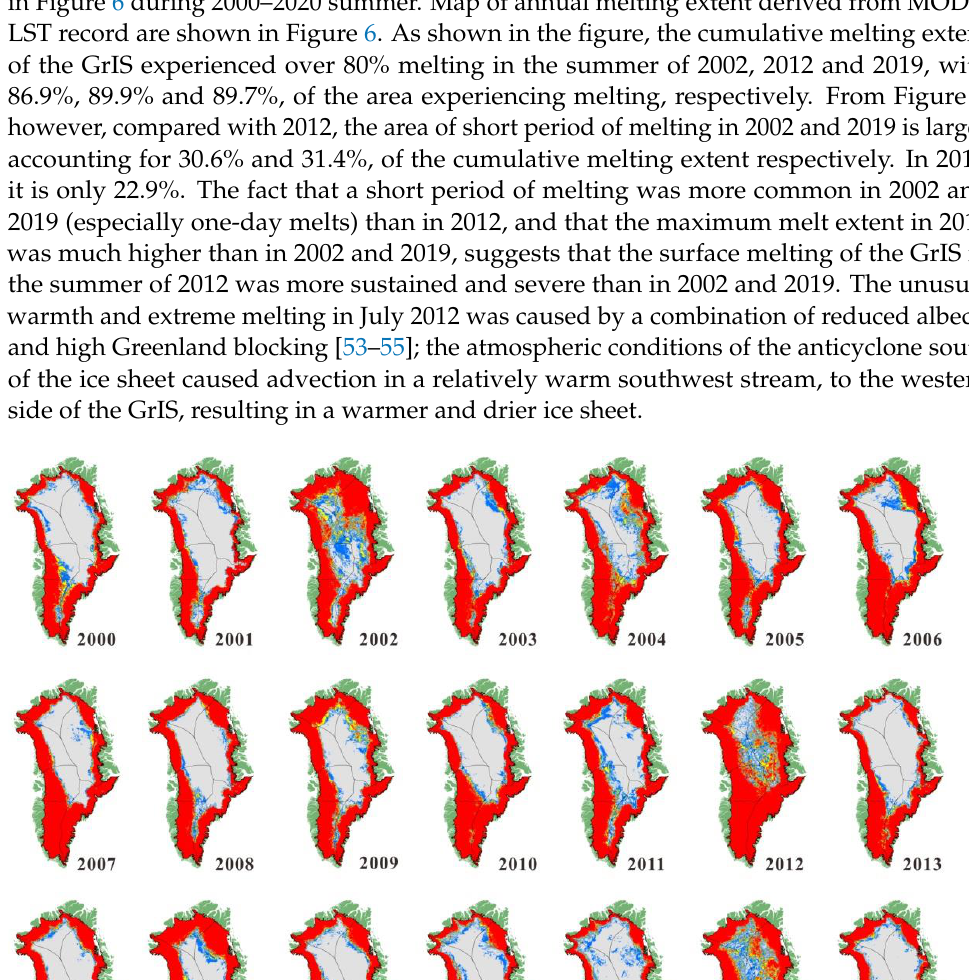
Figure 7. Percentage of the GrIS melting extent for summer from 2000 to 2020. (Extent of maximum melt as derived from the MODIS daily LST). Apparently, in the summers of 2002, 2012 and 2019, the GrIS experienced the most severe melting of the ice sheet. We then compared the surface melting of the ice sheet over the three years in detail, as shown in Figure 8. Positive (negative) day anomaly indicates